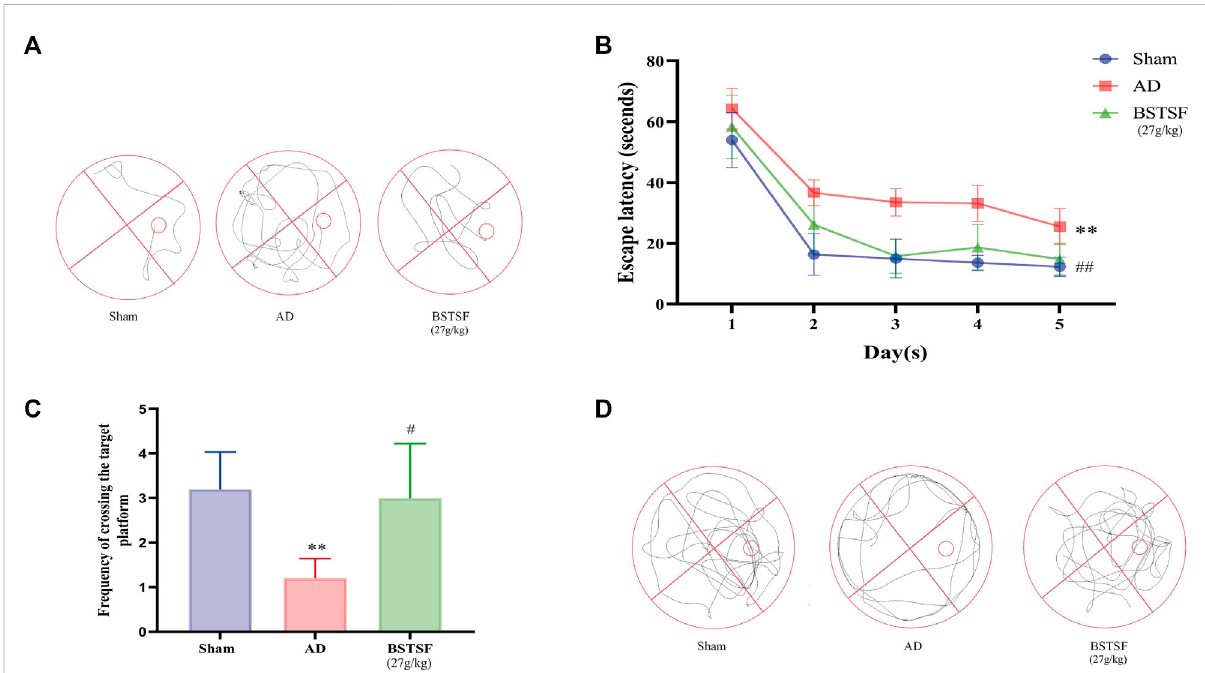
FIGURE 1 BSTSF ameliorates cognitive de fi ciency. (A) representative images of swimming paths; (B) time spent fi nding the hidden platform; (C) the numberofplatformcrossings; (D) representativeimagesofthefrequencyofmotiontrack.Dataareexpressedasthemean±SD(n=5). pp p < 0.01 vs . sham group; # p < 0.05, ## p < 0.01 vs . AD